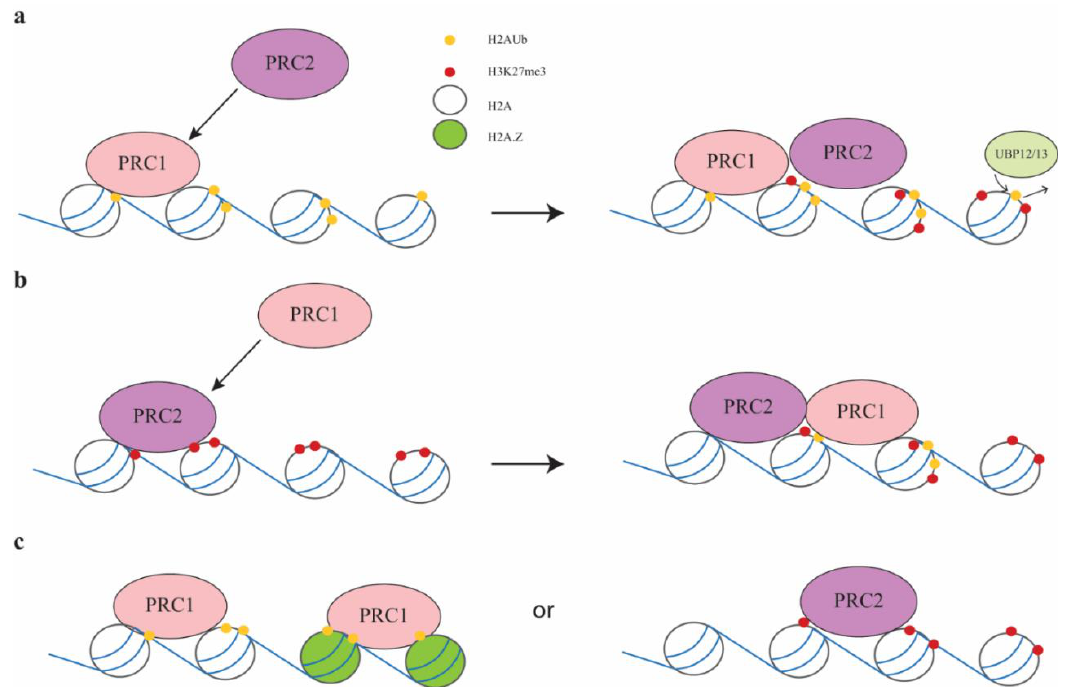
Figure 1. Model of PRC1 and PRC2 interactions. ( a ) PRC1 acts first and induces ubiquitination of H2A. PRC2 is recruited after PRC1, and H3K27me3 is deposited. H2Aub is then removed by UBP12/13 to maintain H3K27me3. ( b ) PRC2 acts first and deposits H3K27me3; PRC1 is recruited by H3K27me3; and H2A is ubiquitinated afterwards. ( c ) PRC1 and PRC2 act independently of each other. Both H2A and H2A.Z could be